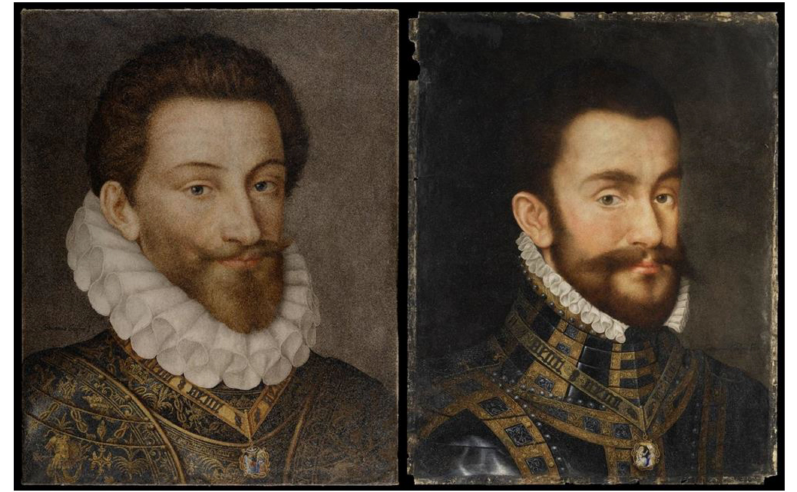
Figure 1. Portraits of Carlo Emanuele I on the left , and Emanuele Filiberto, on the right